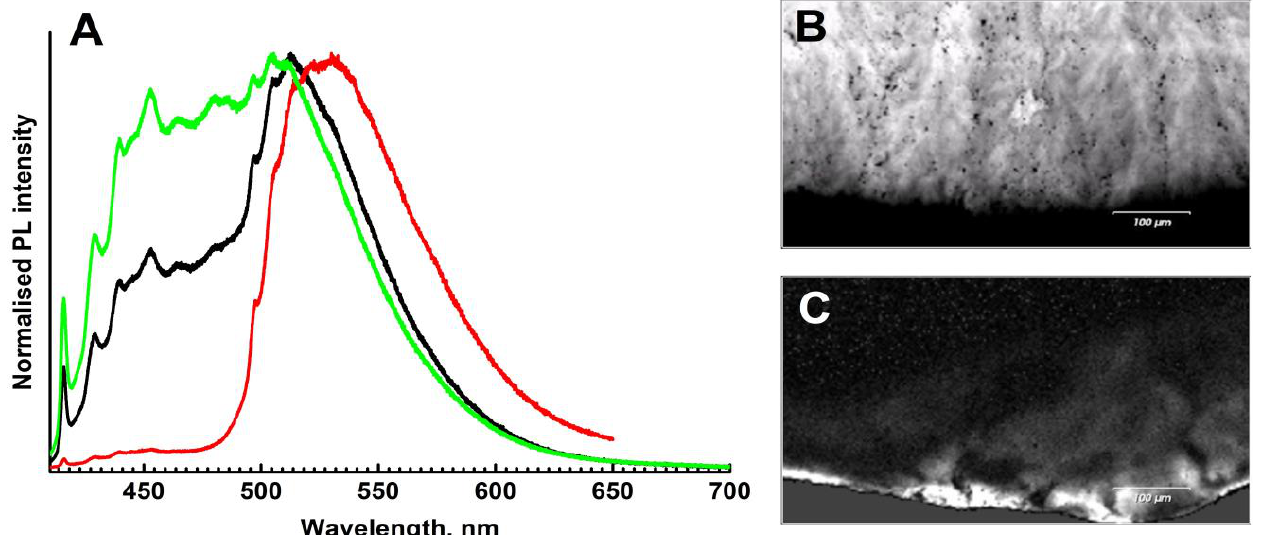
Figure 10. Photoluminescence spectra and maps, λ exc = 405 nm. ( A )—representative spectra of different spots; intensities are normalized to the [0, 1] interval. ( B )—map of the N3 defect distribution (spectral range 414–419 nm); ( C )—distribution of the H4 defect.